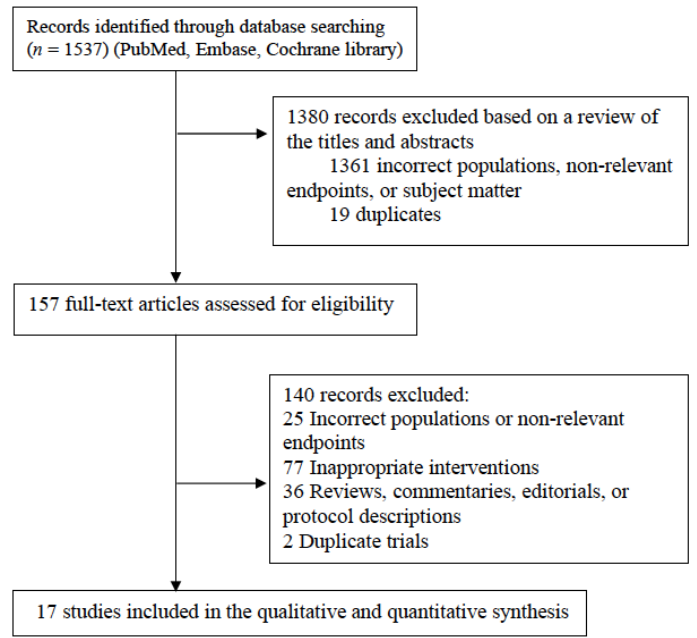
Figure 1. Preferred Reporting Items for Systematic Reviews and Meta-Analyses (PRISMA) guidelines flowchart summarizing study identification and selection.